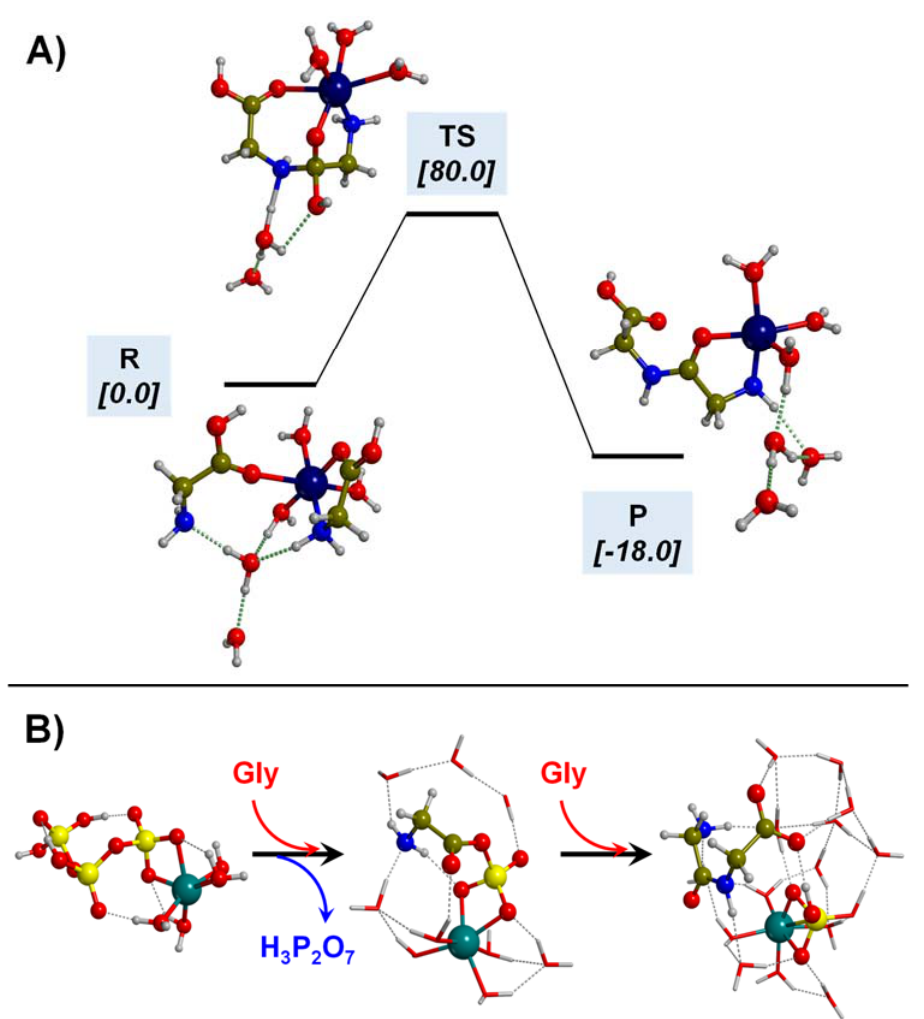
Figure 11. ( A ) Free energy profile at 298 K (in kJ mol − 1 ) in the presence of Cu 2+ and in water solution (adapted from Ref. [229]). ( B ) Schematic representation of the peptide bond formation between two Gly molecules intermediated by the formation of phosphoglycine (species at the centre of the sequence) in the presence of Mg 2+ cation and in water solution (adapted from Ref. [230]).